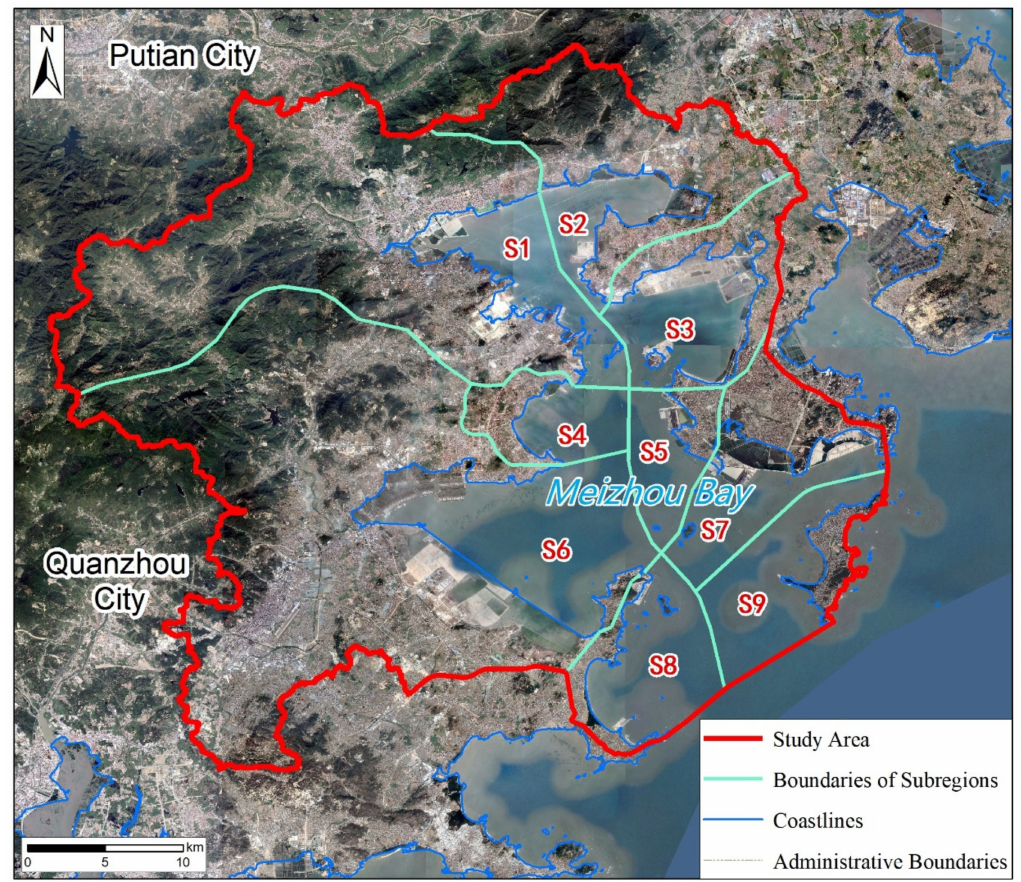
Figure 4. Final boundaries of the nine subregions.